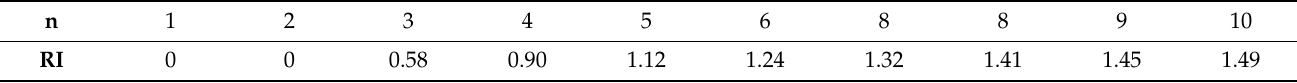
Table 4. Randomly generated values of consistency index ( RI